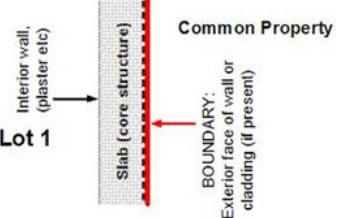
Figure 3. The legal boundary defined by exterior face of the